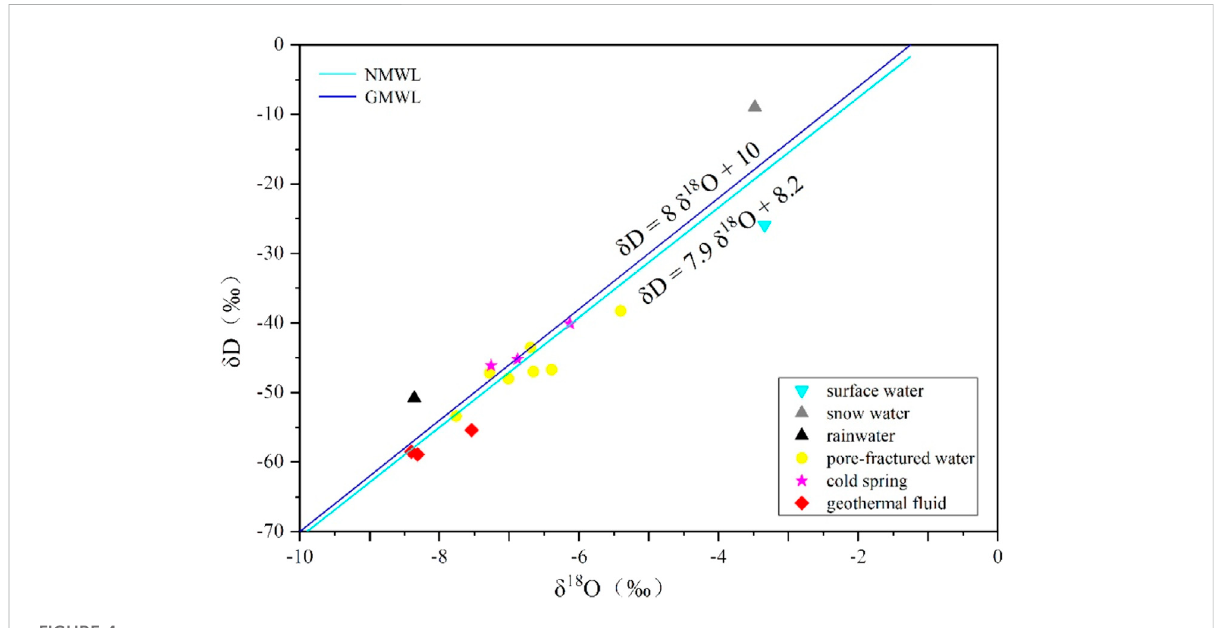
FIGURE 4 Relationship between δ D and δ 18 O content.